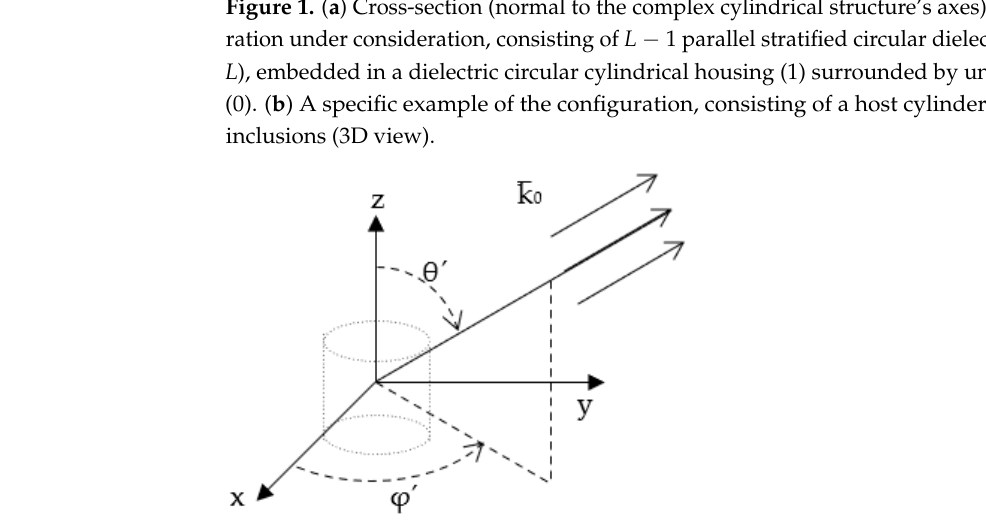
Figure 2. Geometry of the arbitrarily polarized and obliquely incident plane wave impinging upon the general cylindrical structure of Figure 1.